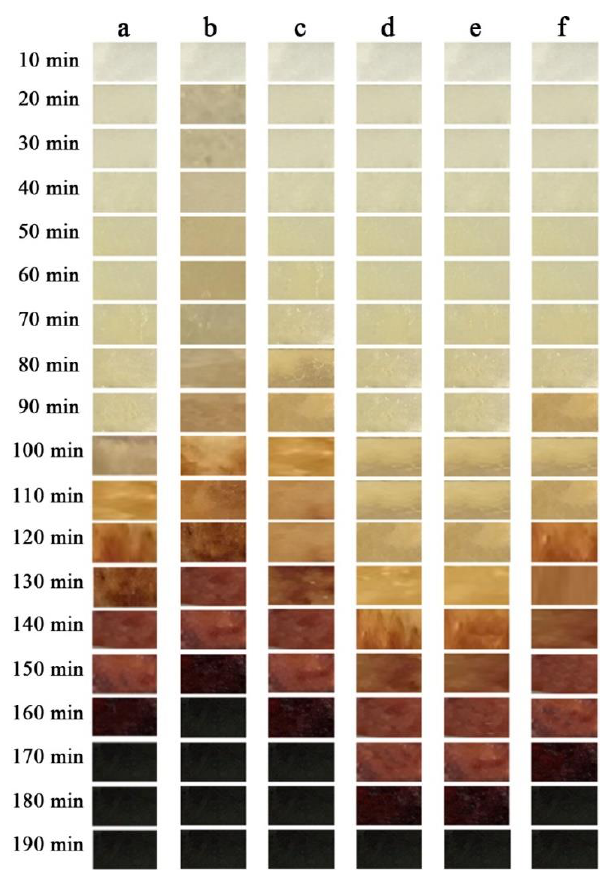
Figure 9. Thermal stability of ( a ) PVC + commercial LDHs + ZnSt 2 , and composite PVC + experimentally prepared LDHs + ZnSt 2 + ( b ) 0, ( c ) 0.1, ( d ) 0.2, ( e ) 0.3 and ( f ) 0.4 phr Zinc acetylacetonate.